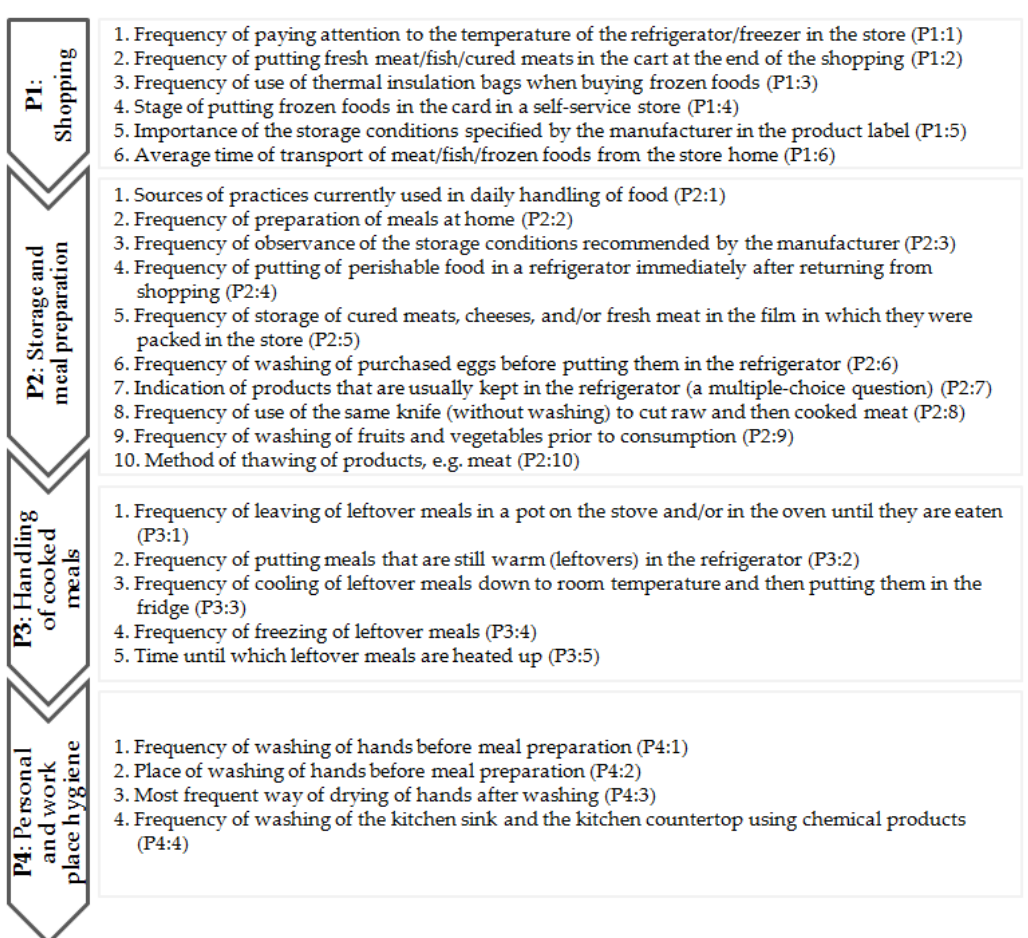
Figure 1. Arrangement and designation of issues covered by the consumer practice part of the questionnaire (P).